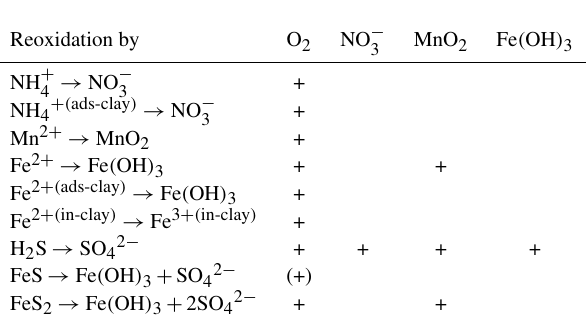
Table 6. Reaction network of secondary redox reactions in the sed- iment, giving the possible reoxidation processes in the presence of the oxidants listed in the first row.